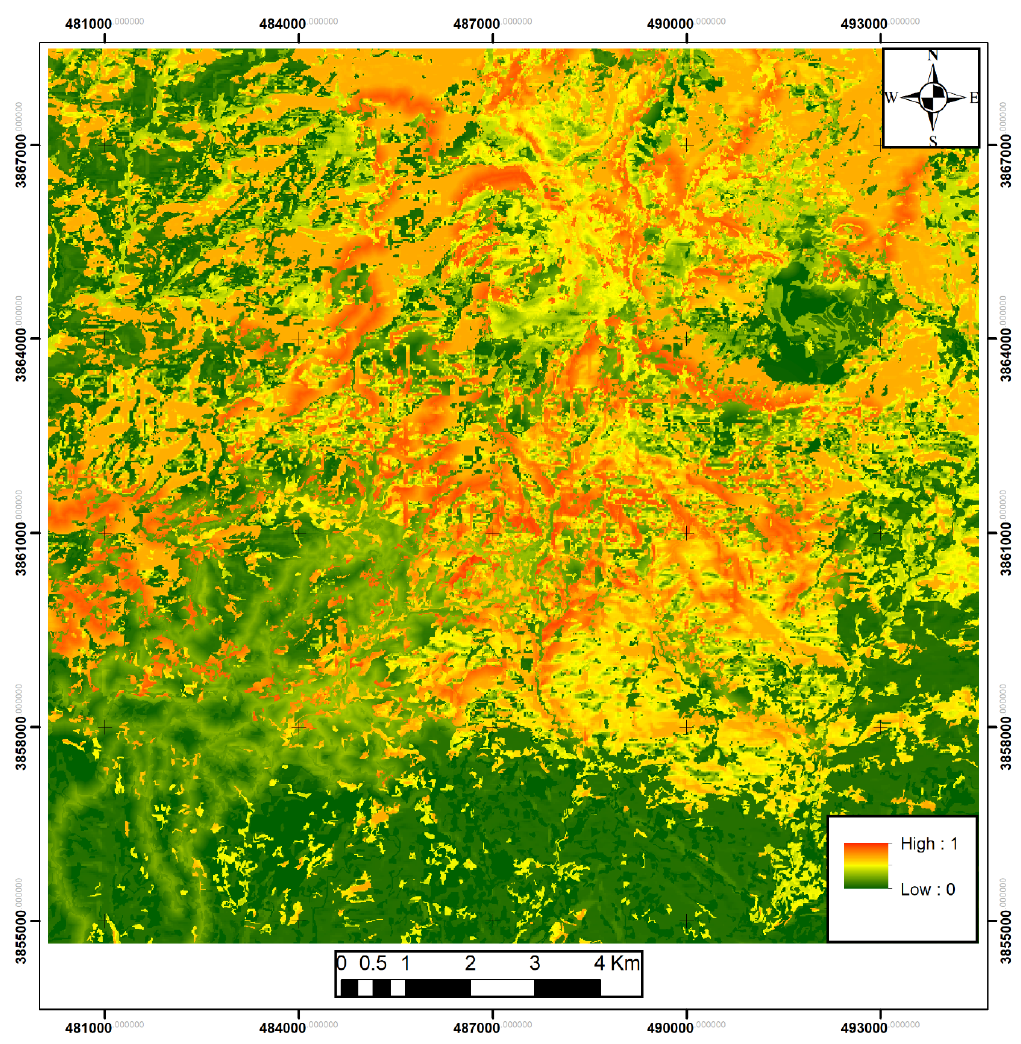
Figure 4. Spatially explicit index of fire hazard in the study area.